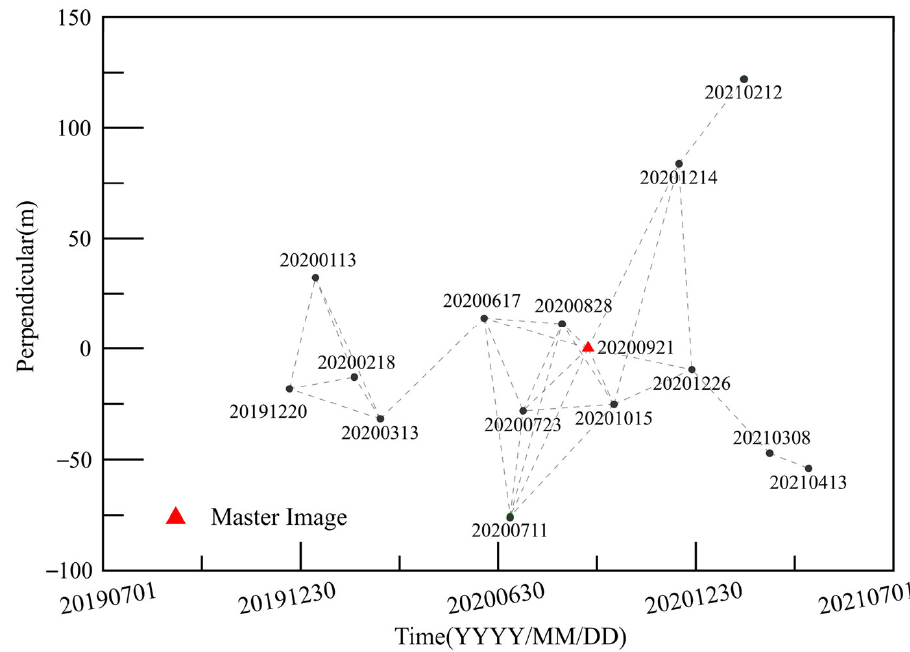
Figure 4. Spatial and temporal baselines of Sentinel-1 descending data.